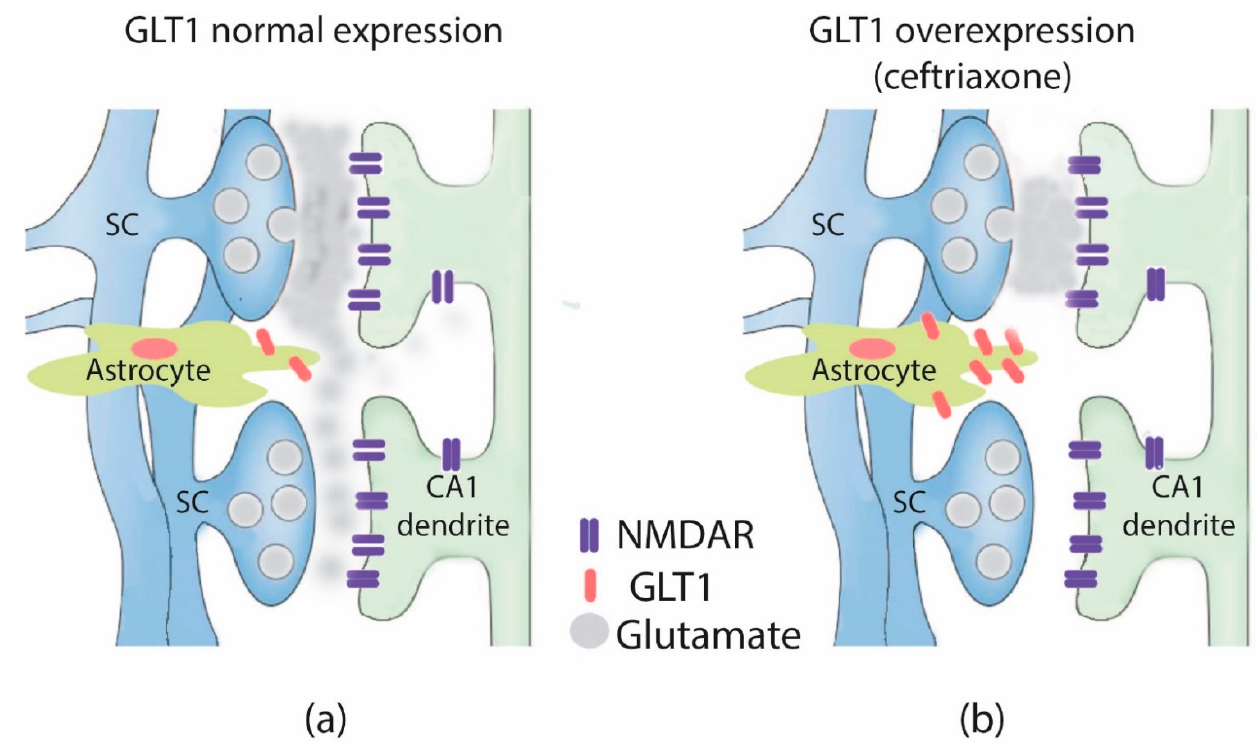
Figure 7. A scheme illustrating the attenuation of the glutamate spillover with GLT1 expression increase. In control, glutamate released from neighboring terminals might pool and spill over to adjoining synapses and extrasynaptic receptors ( a ), while GLT1 overexpression attenuates the glutamate spillover ( b ). For simplicity, only NMDA receptors are shown. SC-Schaffer collateral, GLT1-glutamate transporter